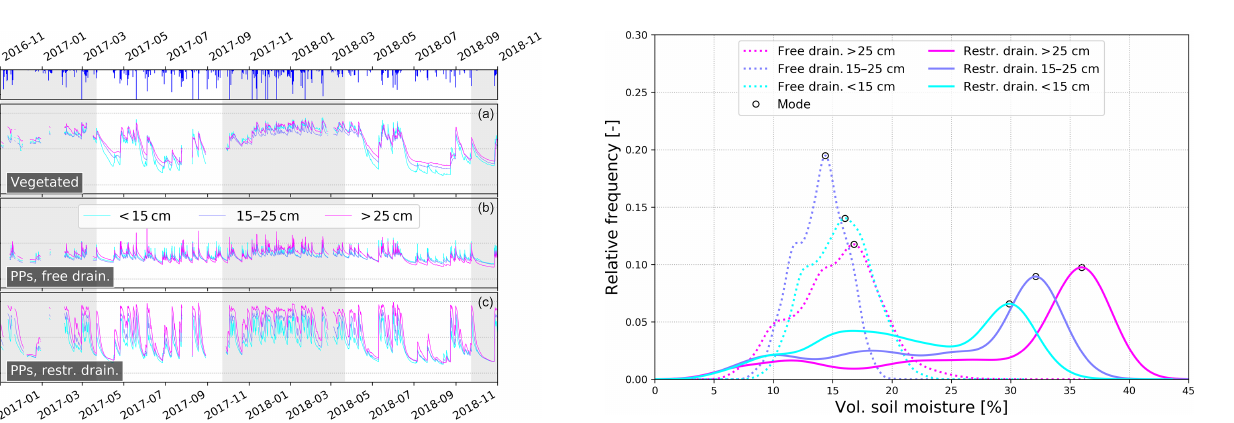
Figure 7. Density distribution of θ values measured at PPs during rain events depending on drainage behavior and sensor depth. De- picted densities are mean values of all sensors within each category.